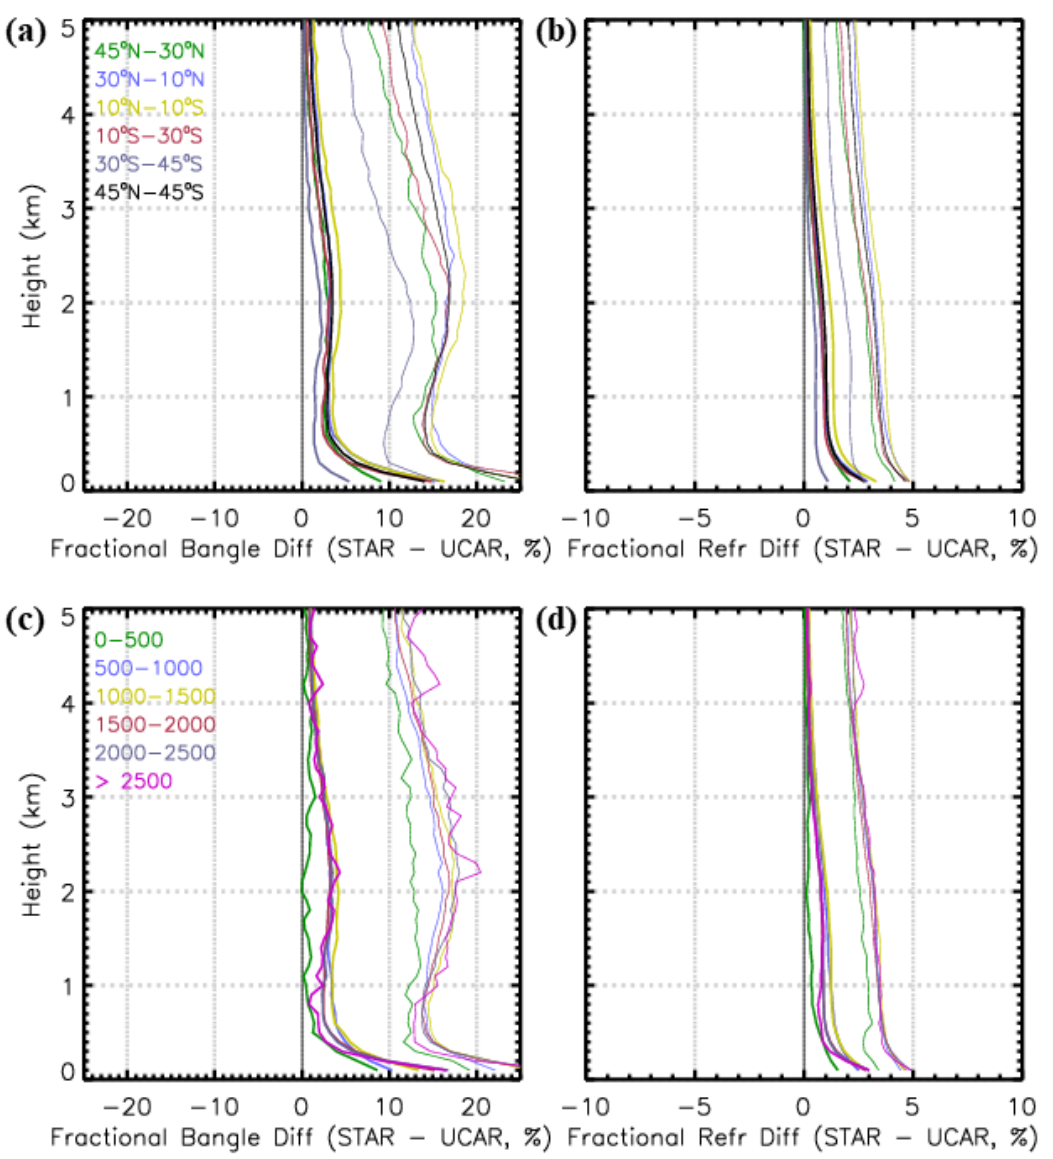
Figure 16. Same as Figure 13, but for the STAR–UCAR fractional